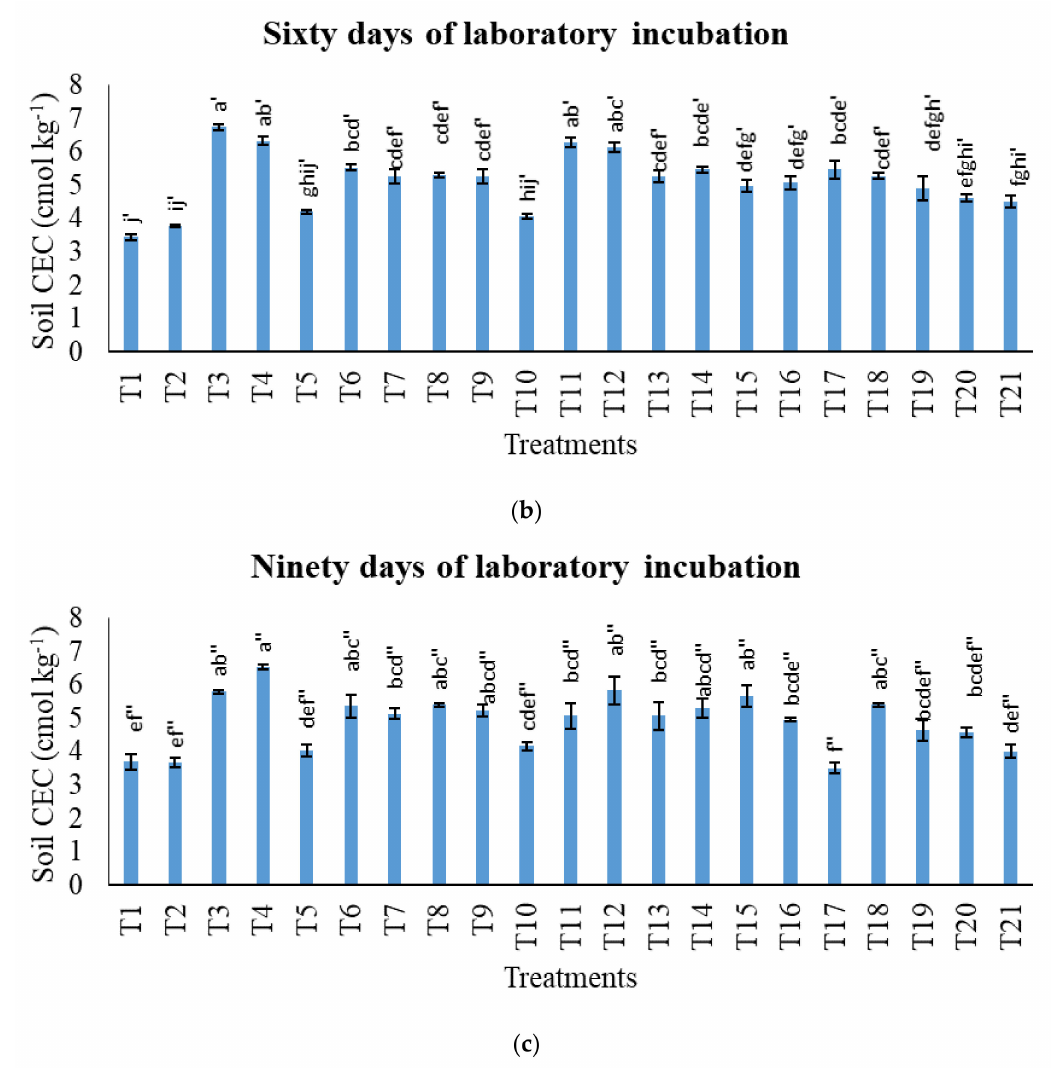
Figure 5. Effects of treatments on soil cation exchange capacity over ( a ) thirty; ( b ) sixty; and ( c ) ninety days after incubation. T1: soil control, T2: conventional practice, T3: muriate of potash + 100% charcoal + 100% sago bark ash, T4: muriate of potash + 100% sago bark ash, T5: muriate of potash + 100% charcoal, T6: muriate of potash + 80% charcoal + 80% sago bark ash, T7: muriate of potash + 60% charcoal + 80% sago bark ash, T8: muriate of potash + 40% + 80% sago bark ash, T9: muriate of potash + 20% charcoal + 80% sago bark ash, T10: muriate of potash + 80 charcoal + 60% sago bark ash, T11: muriate of potash + 60% charcoal + 60% sago bark ash, T12: muriate of potash + 40% charcoal + 60% sago bark ash, T13: muriate of potash + 20% charcoal + 60% sago bark ash, T14: muriate of potash + 80% charcoal + 40% sago bark ash, T15: muriate of potash + 60% charcoal + 40% sago bark ash, T16: muriate of potash + 40% charcoal + 40% sago bark ash, T17: muriate of potash + 20% charcoal + 40% sago bark ash, T18: muriate of potash + 80% charcoal + 20% sago bark ash, T19: muriate of potash + 60% charcoal + 20% sago bark ash, T20: muriate of potash + 40% charcoal + 20% sago bark ash, and T21: muriate of potash + 20% charcoal + 20% sago bark ash. Different letters indicate significant differences between means using Tukey’s HSD test at p ≤ 0.05. The error bars are the ± standard error of triplicates. Letters without any marks and letters with ‘ and ” indicate mean comparison within thirty, sixty, and ninety days after incubation,